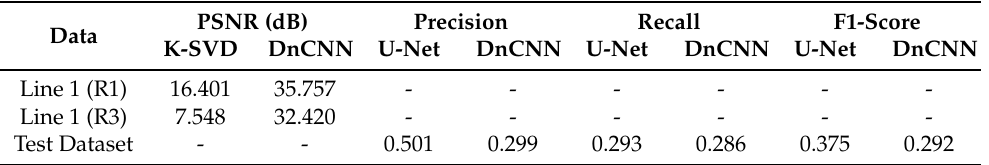
Table 3. Comparisons of the PSNRs of K-SVD and the DnCNN in two radar image slices from Line 1 and the quantitative results of the DnCNN and U-Net on the 10% reserved from the training dataset. PSNR (dB) Precision Recall F1-Score Data K-SVD DnCNN U-Net DnCNN U-Net Line 1 (R1) Test Dataset